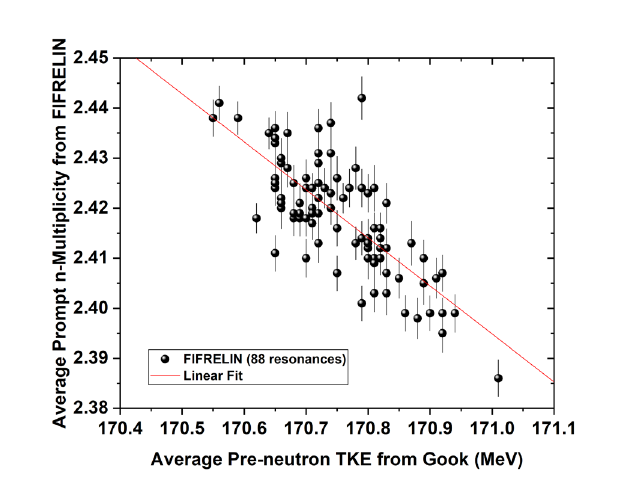
Figure 4. Same as in Fig. 3, but for the 12 more accurate reso- nances (statistical uncertainties lower than 1%). Figure 5. Average prompt neutron multiplicity calculated with FIFRELIN as a function of the average fission fragment total ki- netic energy measured by Göök, for 88 resonances.